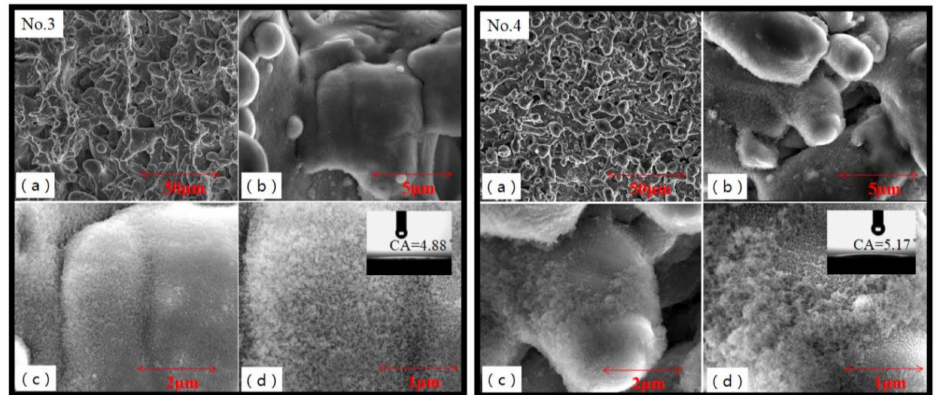
Figure 6. SEM images of No.3 and No.4 samples treated by small spot spacing. Micro spikes and pits were covered with nano structures. Reference bars on these figures from ( a – d ) were 50 µ m, 5 µ m, 2 µ m, and 1 µ m, respectively.